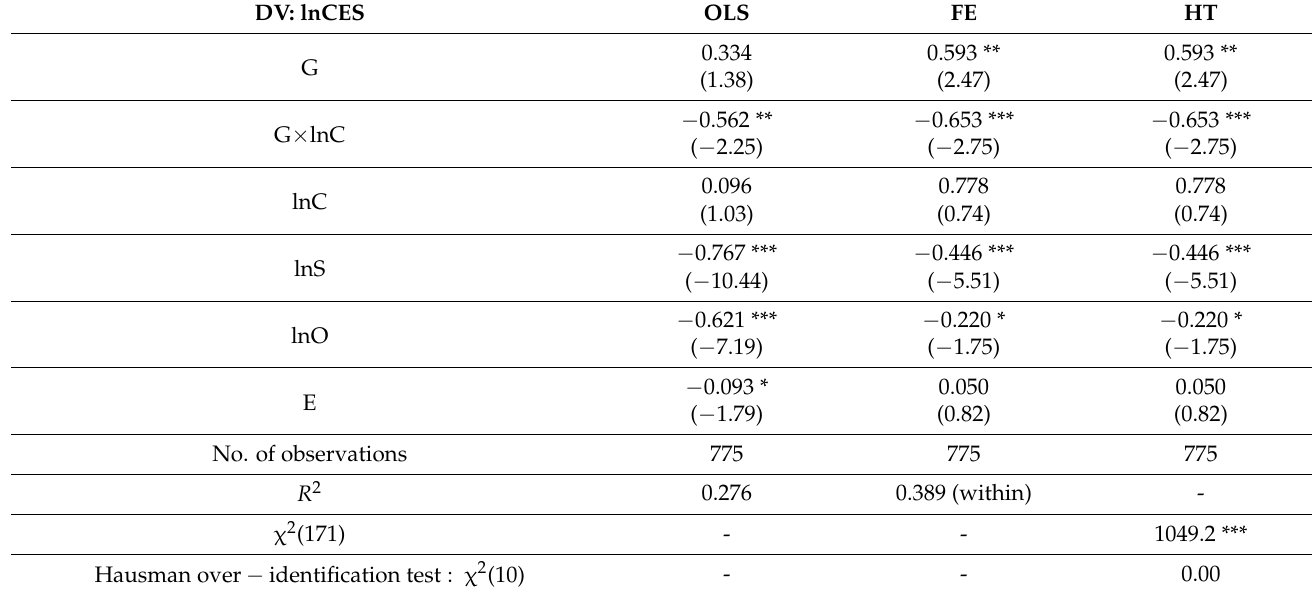
Table 5. Regression results for Equation